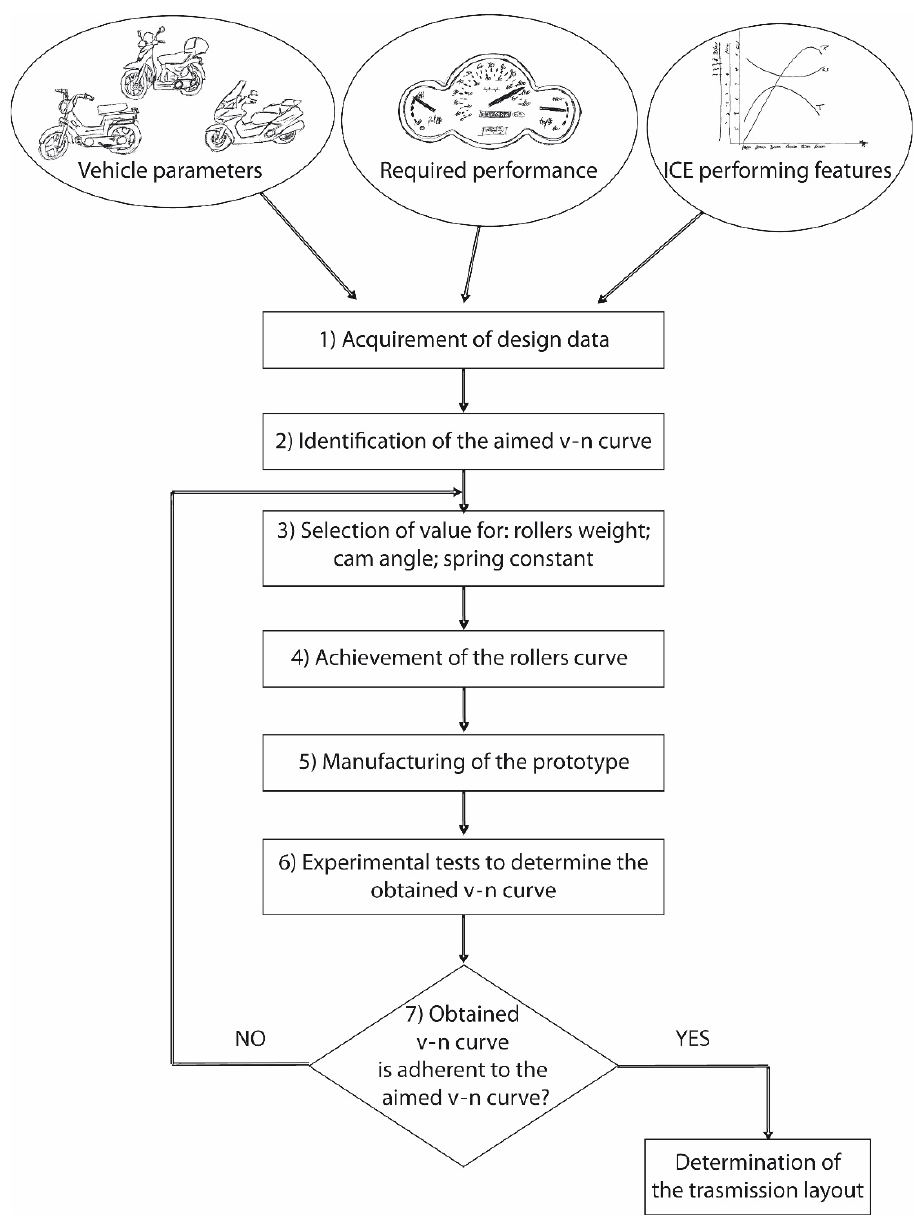
Figure 6 . CVT design flow chart. Figure 6. CVT design flow